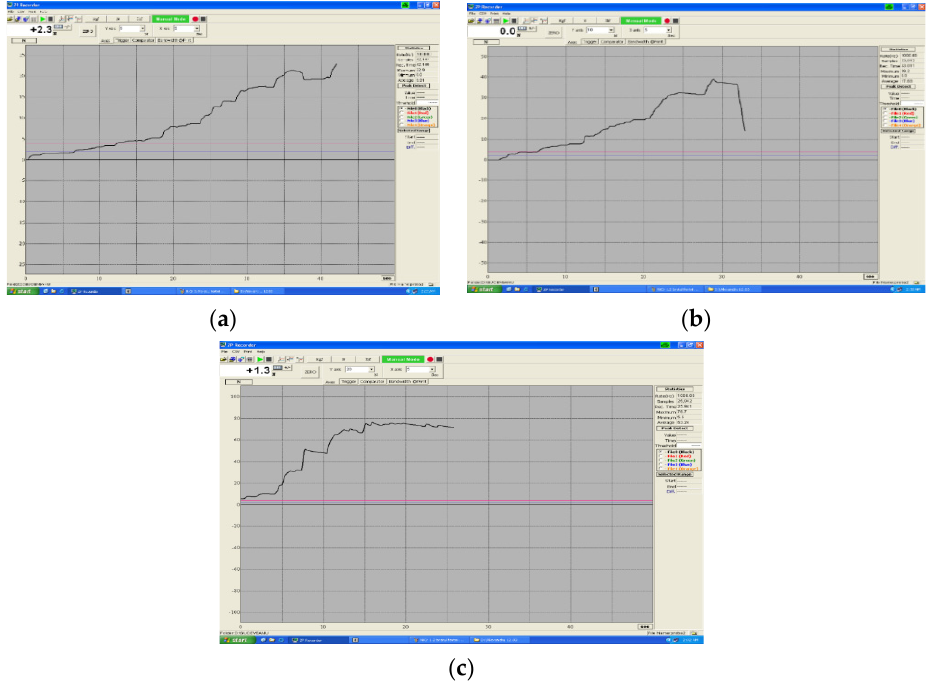
Figure 11. ( a – c ) Evolution of Ni-Cr arc forces, wire diameter 1.2 mm. For the 1.2 mm diameter Cr-Co wire, the changes are shown in Table 6. Table 6. Results for Co-Cr 1.2 mm arches.